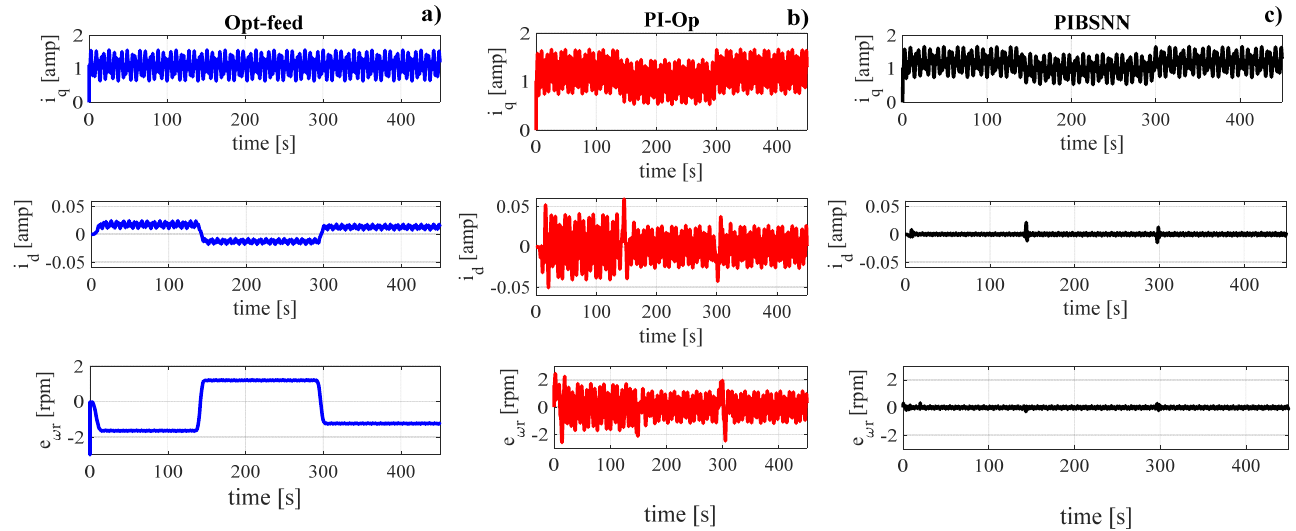
Figure 12. Transient response of currents in the reference frame dq and speed error for the PMSM subjected to abrupt